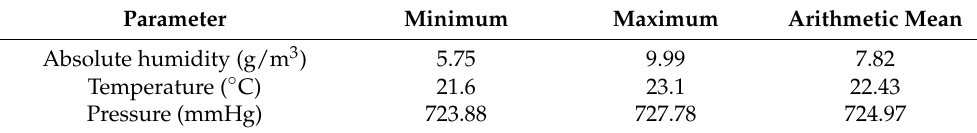
Table 4. Measured ambient conditions for breakdown experiments with needle–plane electrode system.